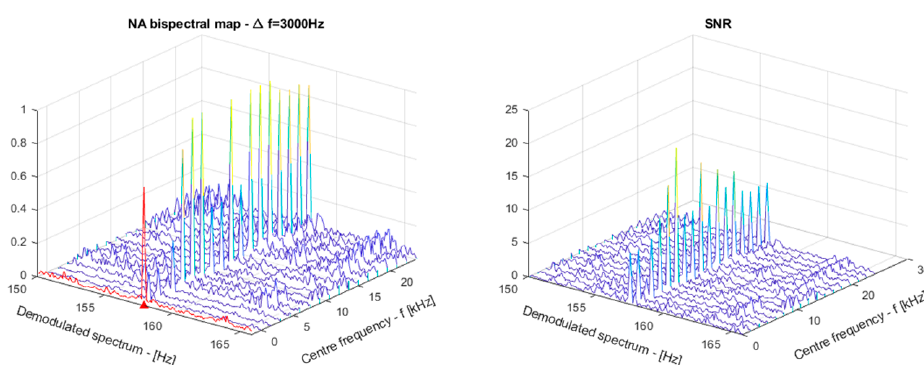
Figure 4. Bispectral demodulation maps of normalized amplitudes and signal to noise ratio given a fixed ∆ f while the center frequency is increasing from 0 to half the sampling frequency. In the first picture, the average curve is displayed in red and the resulting exact damage frequency f d is highlighted by the red triangle.